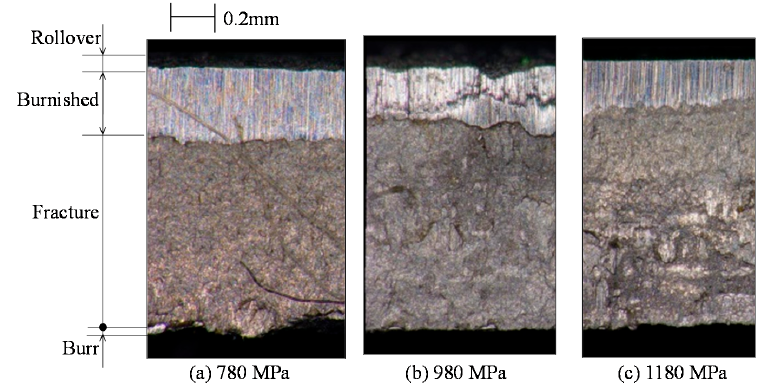
Figure 9. Sheared edge of steel sheet.